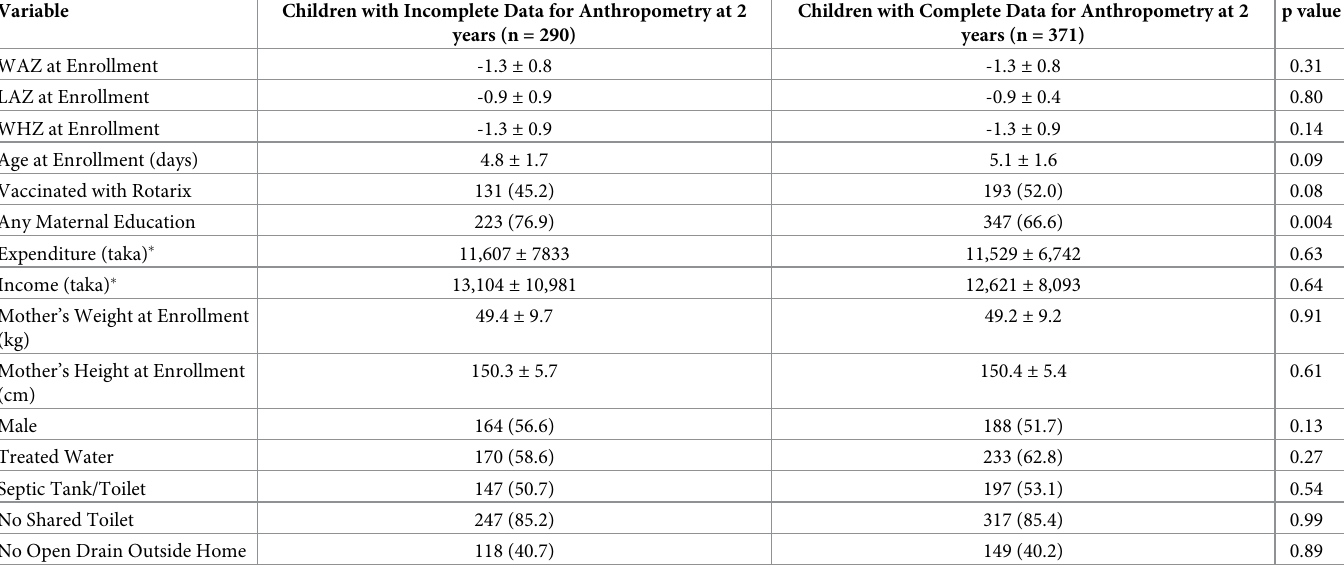
Table 2. Enrollment characteristics of children who completed 2 year anthropomorphic assessments compared with those who did